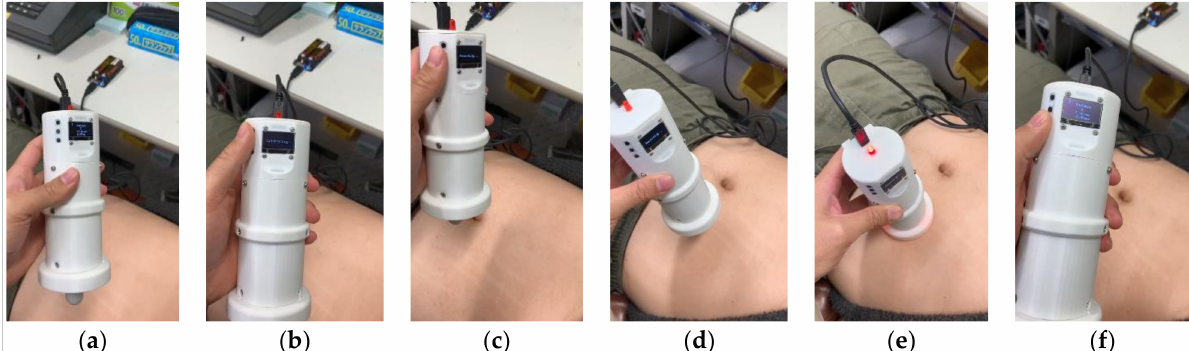
Figure 9. Evaluation steps for abdominal stiffness evaluation. ( a ) Power on and prepare to measure. ( b ) Correct zero-point value by pressing zero-point adjustment button. ( c ) Start recording by pressing record button. ( d ) Press specified area on abdomen. ( e ) Stop pressing when LEDs for all contact detection sensors are lit. ( f ) Stop evaluation and data recording by pressing stop